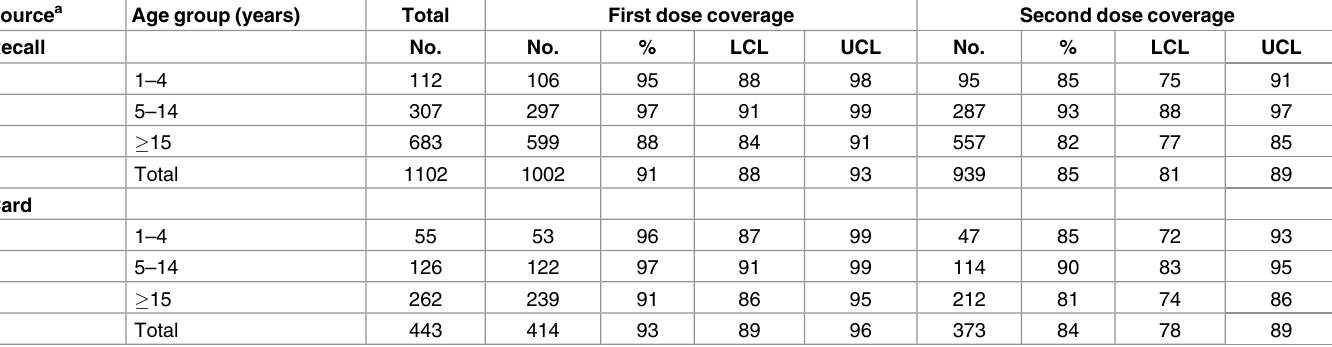
Abbreviations: LCL = lower confidence limit; UCL = upper confidence limit a Household respondents’ recall was collected for all household members first, followed by reviewing individualvaccination cards, ("card" responses are the subset of "recall" with